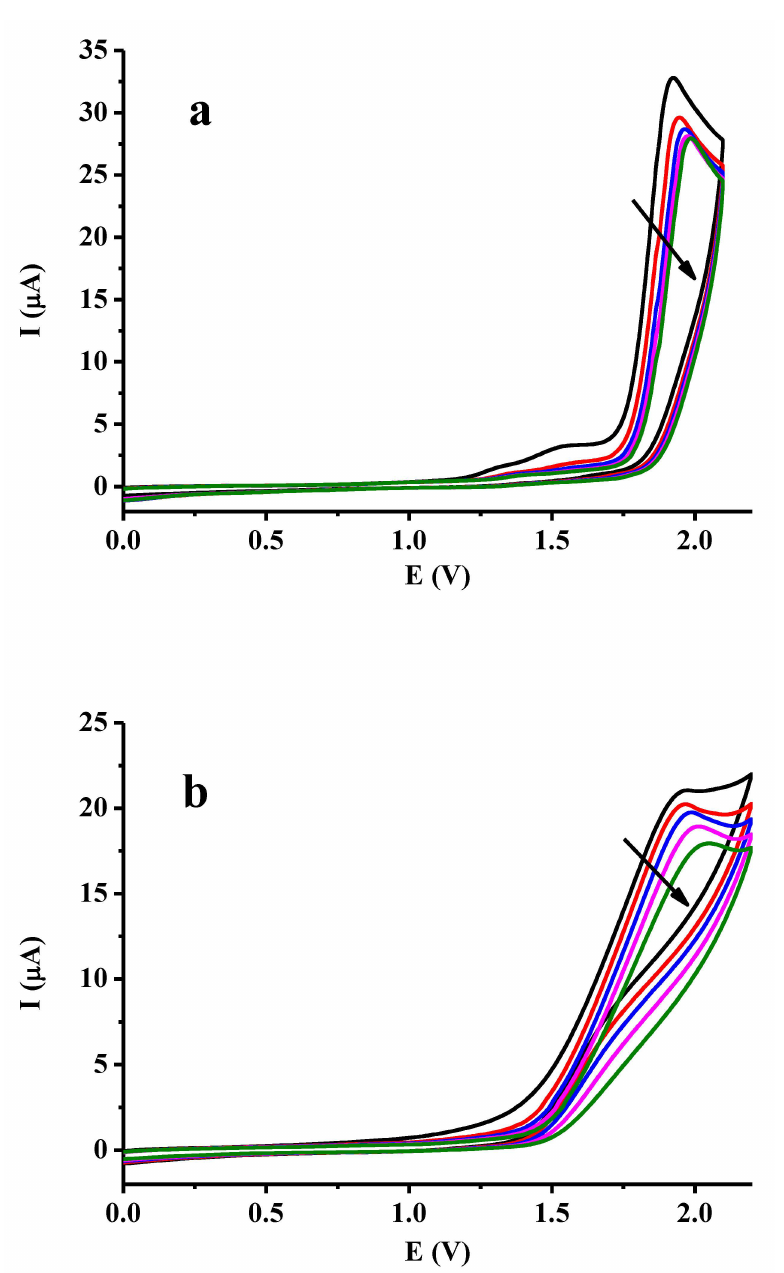
Figure 1. Subsequent cyclic voltammograms of 10 mmol/L dibenzoylmethane in acetonitrile ( a ), and in 1-propanol ( b ) (scan rate 0.1 V/s, supporting electrolyte 0.05 M TBAP) without polishing between